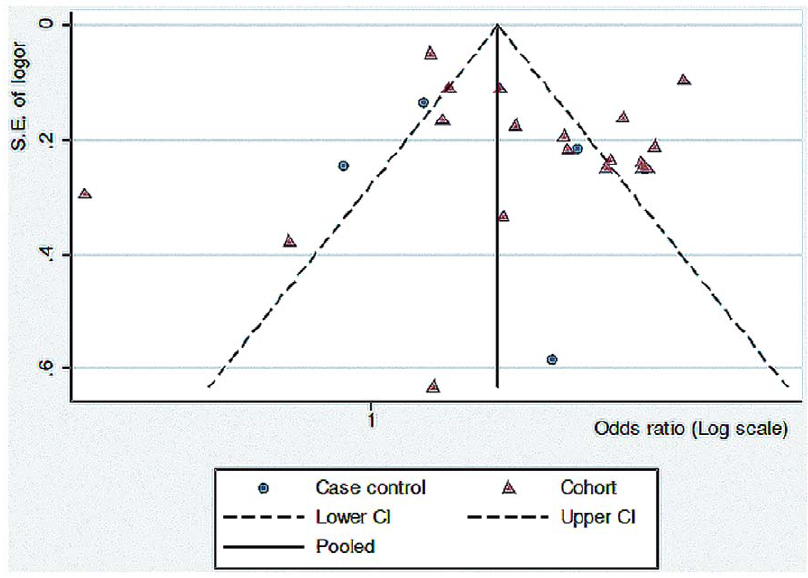
Figure 5. Funnel plot of incidence studies of dementia and education.